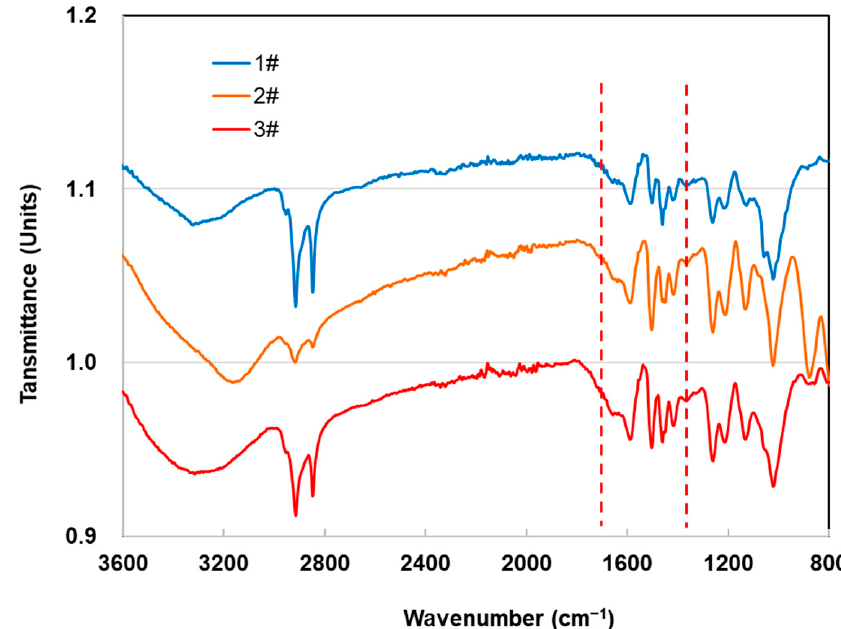
Figure 3. FTIR spectra of ancient shipwreck wood from Huaguang Jiao No. 1.